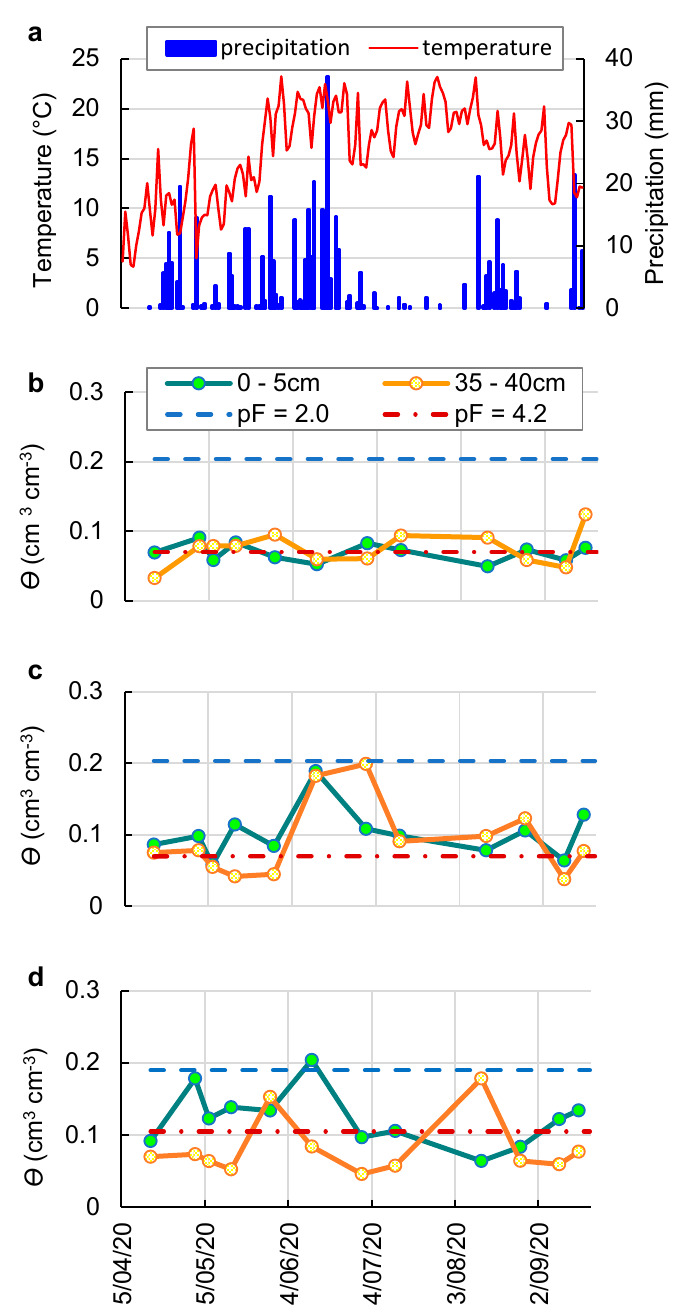
Figure 2. The sum of daily precipitation and mean daily temperature recorded at the nearest meteorological station ( a ) the mean soil moisture content ( θ ) for two mineral layers of soil under different plant cover, (( b ) S1– Dicrano-Pinion , ( c ) S2— Scleranthion annui , and ( d ) S3— Molinio-Frangulion ) from April, 2020 to September, 2020. Note: presented pF values are for 0–5 cm soil layer.